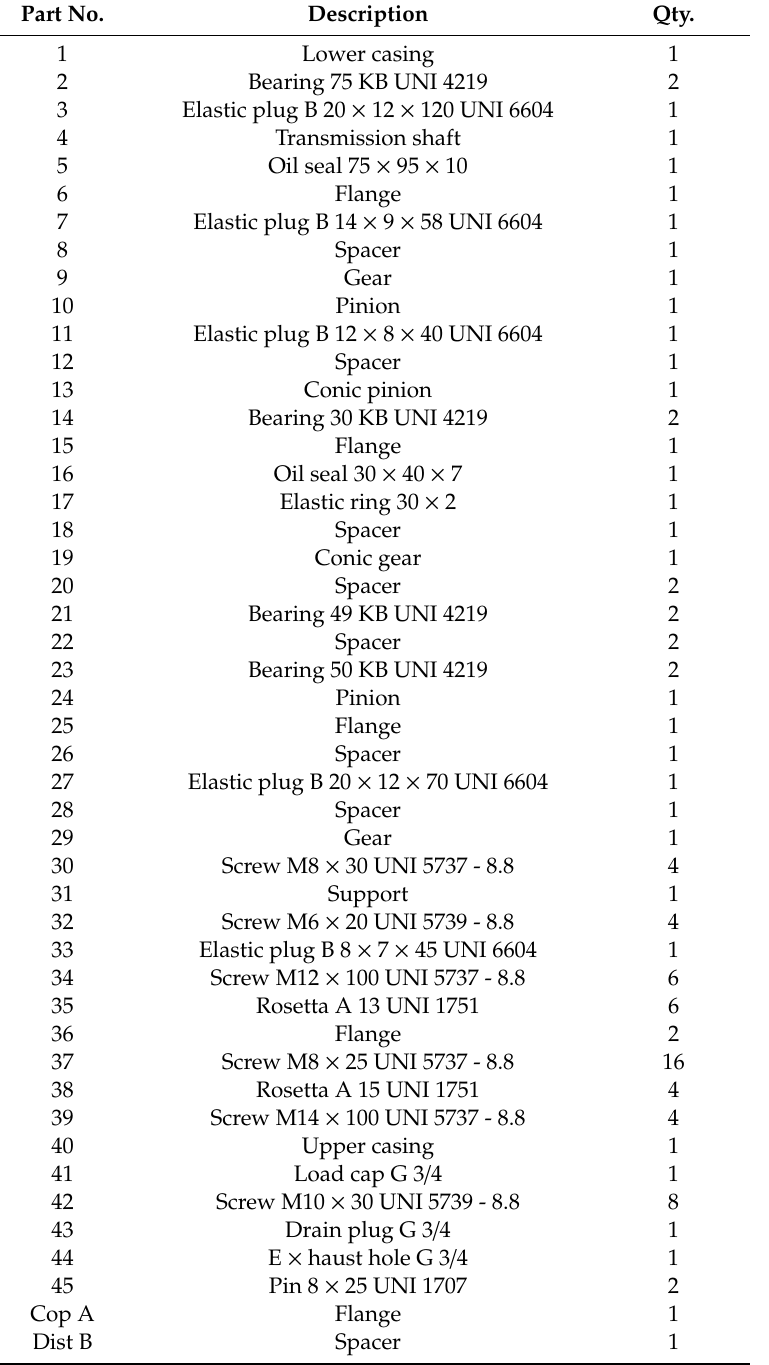
Table 1. The Bill of Material of the speed gearbox. Part No. Description